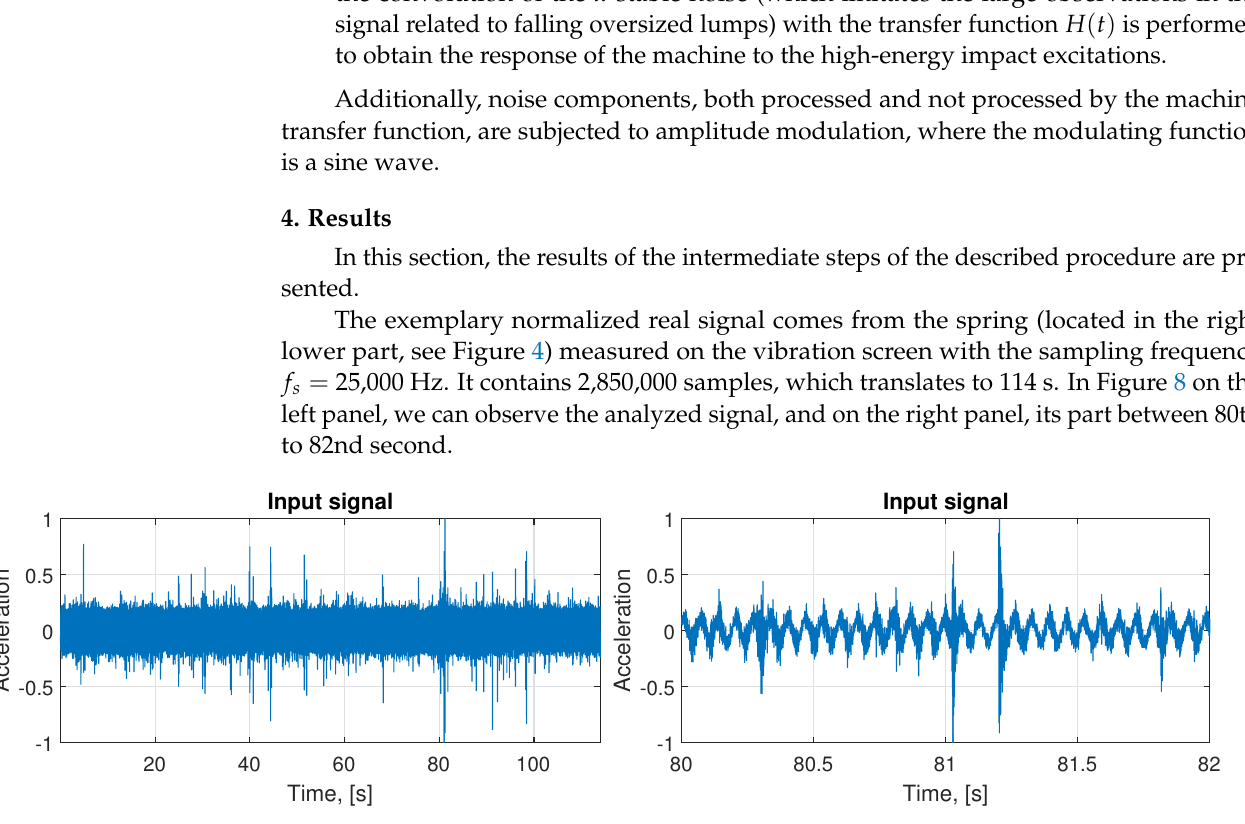
Figure 8. The raw input signal (left panel) and its two seconds part (right panel).